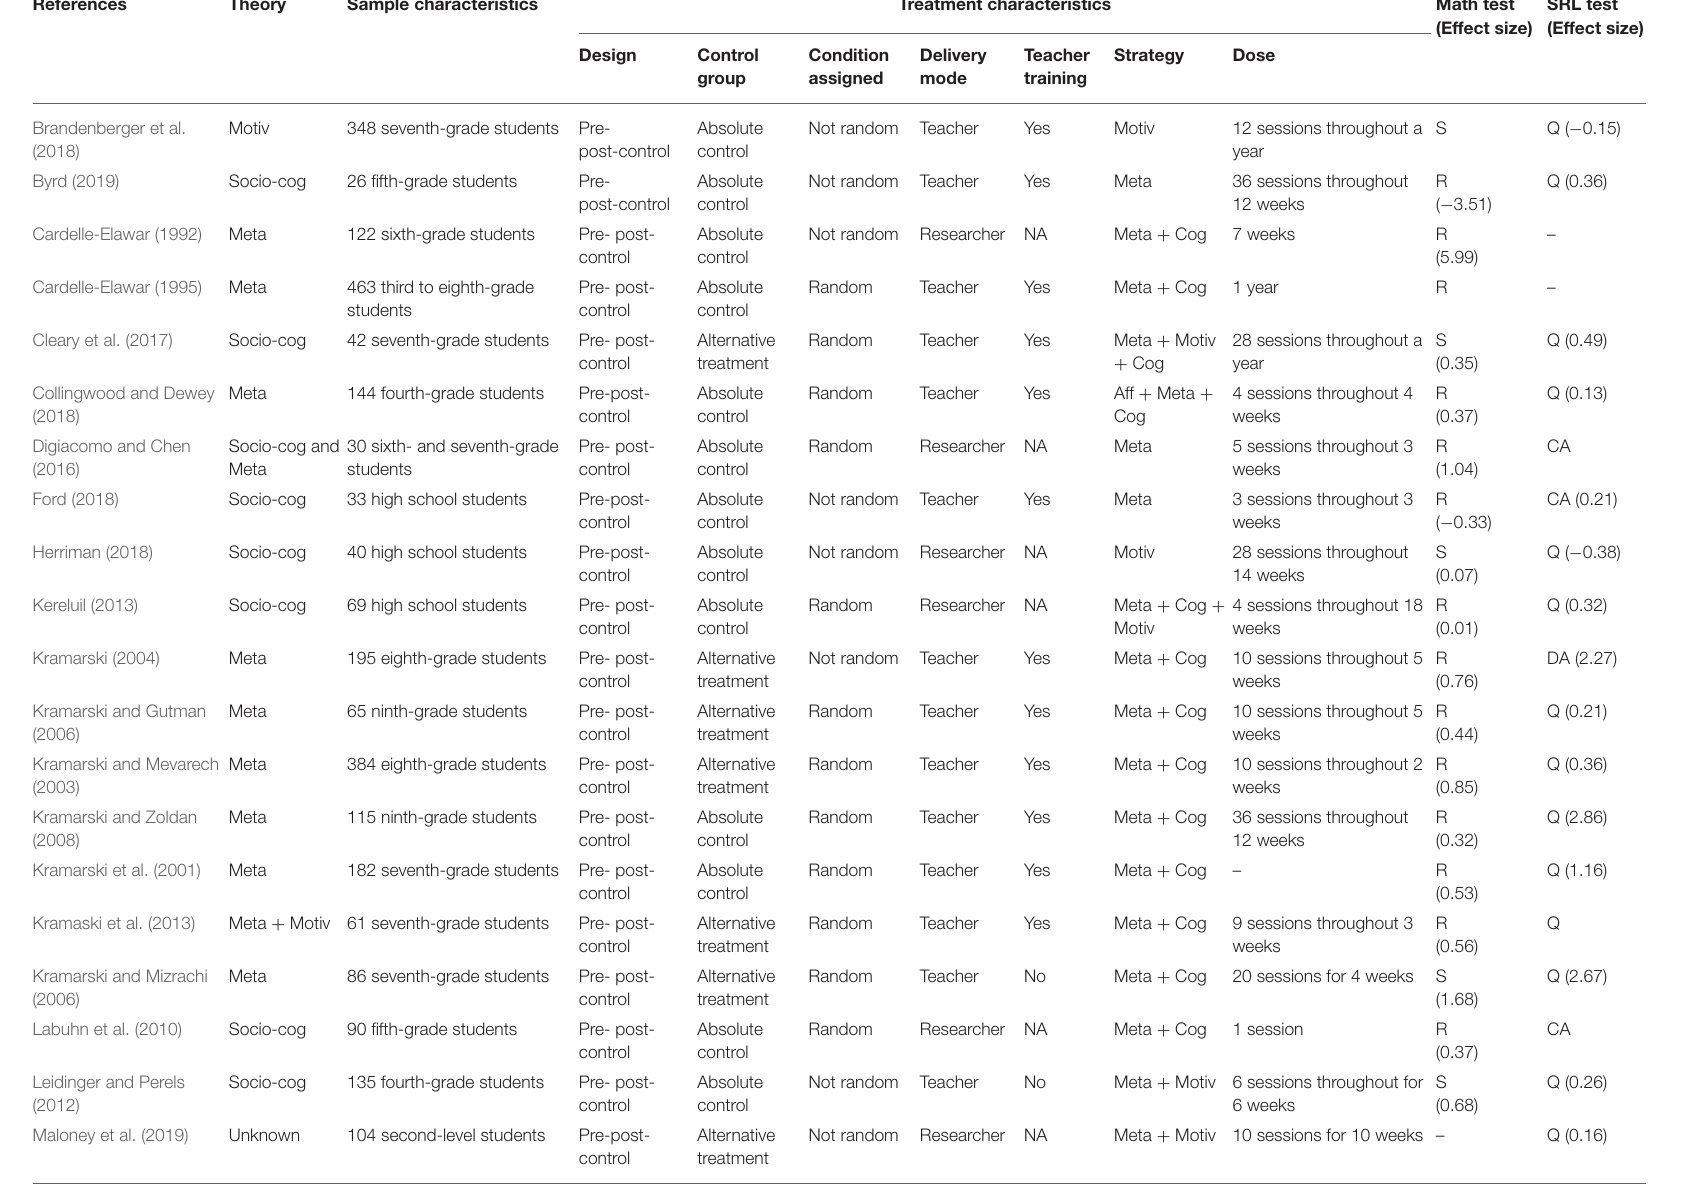
TABLE 4 | Coding information of the identified